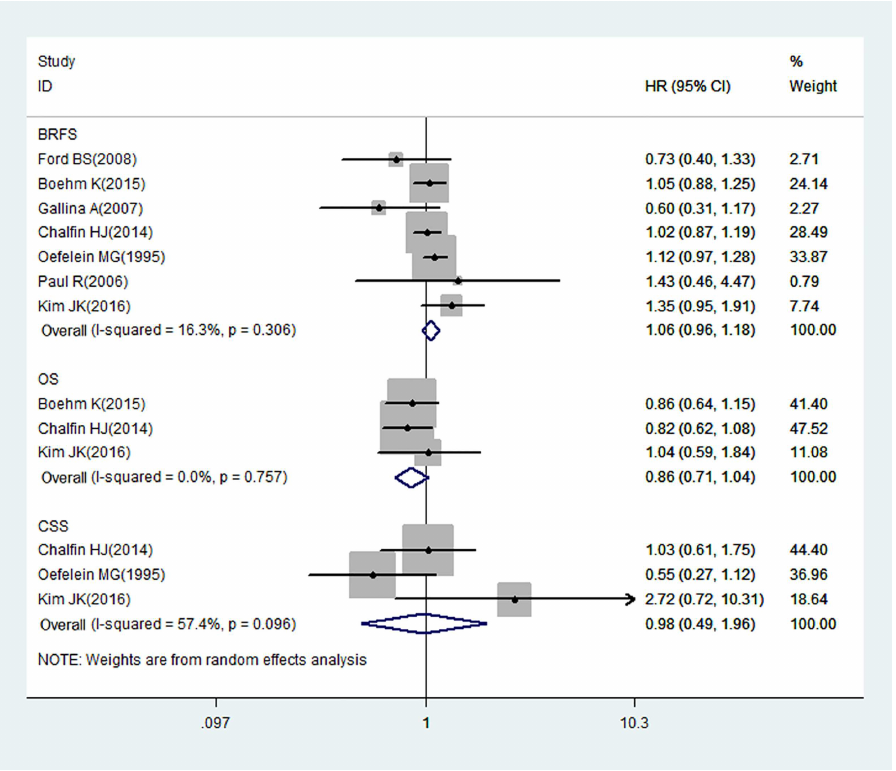
Fig 2. Random-effects model forest plots showing the impact of autologous BT on PCa survival after